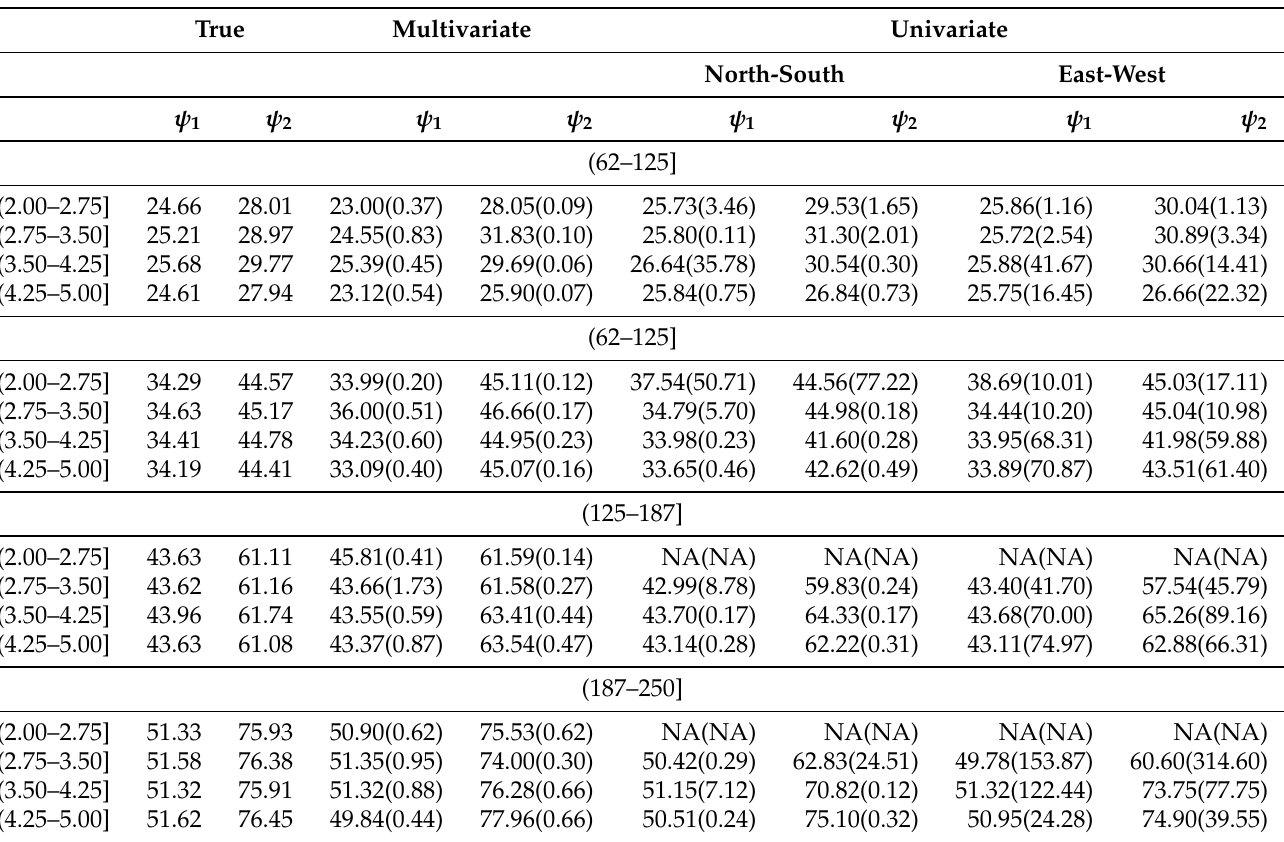
Table 2. Empirical means and mean squared error values (in round brackets) for the two relevant change points over the two horizontal components (North–South and East–West) in each simulated scenario, expressed in